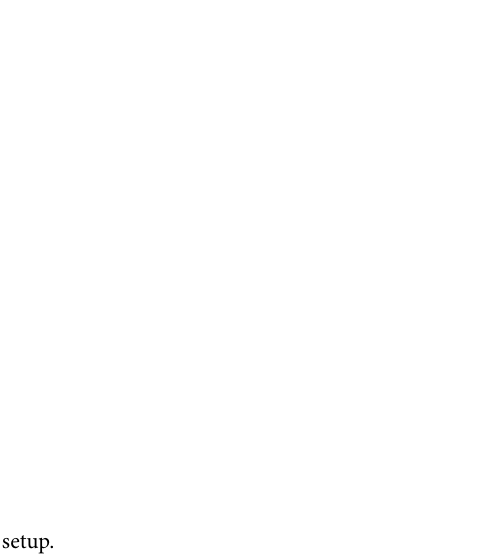
Figure 3. ( a ) Schematic of experimental/diagnostic setup; all dimensions are in mm. ( b ) Schematic flow from diagnostic/simulation tools to the analysis parameters.